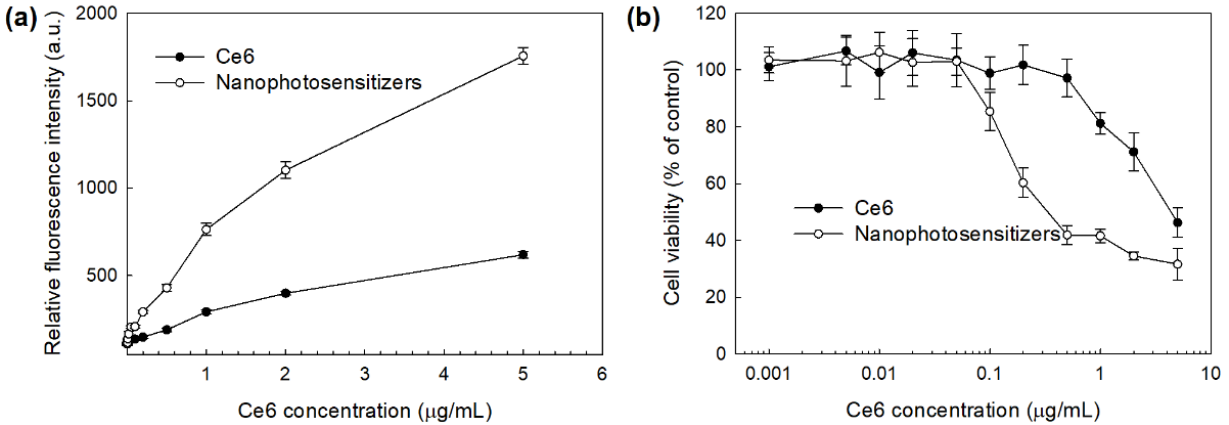
Figure 9. PDT efficacy of Ce6 and mPEGseseCe6PBAP nanophotosensitizers against HeLa human cervical cancer cells. ( a ) intracellular ROS generation; ( b ) PDT against HeLa cells. DCFH-DA assay was employed to measure ROS generation in cells. Cells (2 × 10 4 cells/well) were irradiated at 664 nm (2 J/cm 2 ).